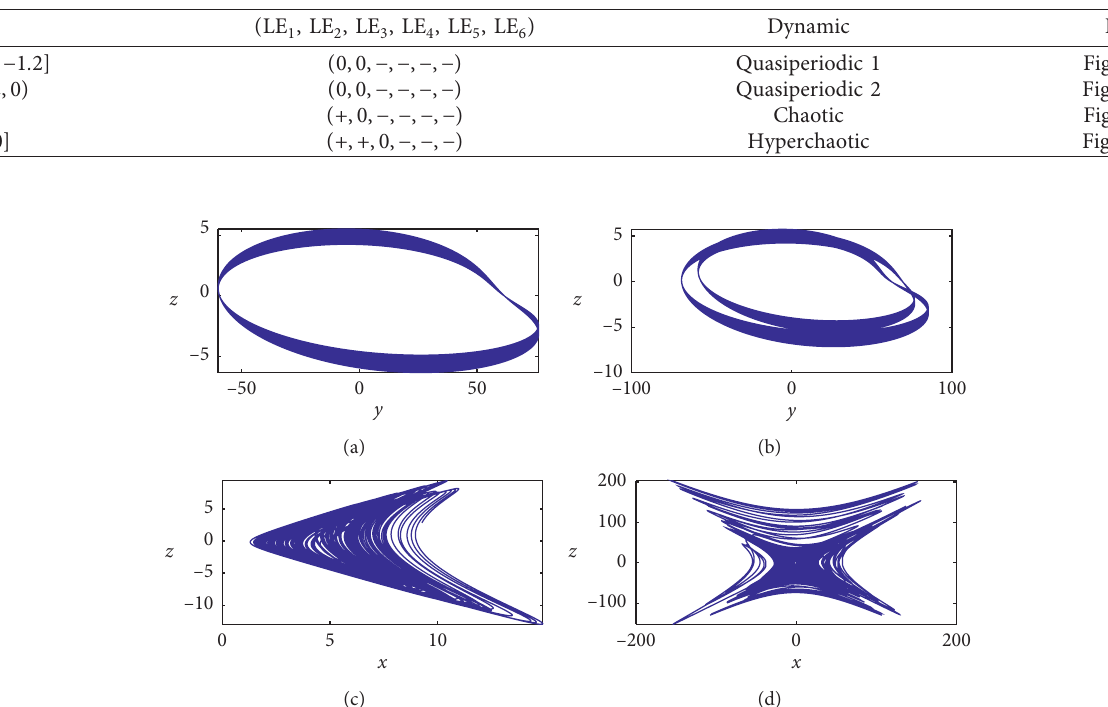
Figure 4: The phase portraits: (a) quasiperiodic 1, (b) quasiperiodic 2, (c) two-wing chaotic attractor, and (d) four-wing hyperchaotic attractor.